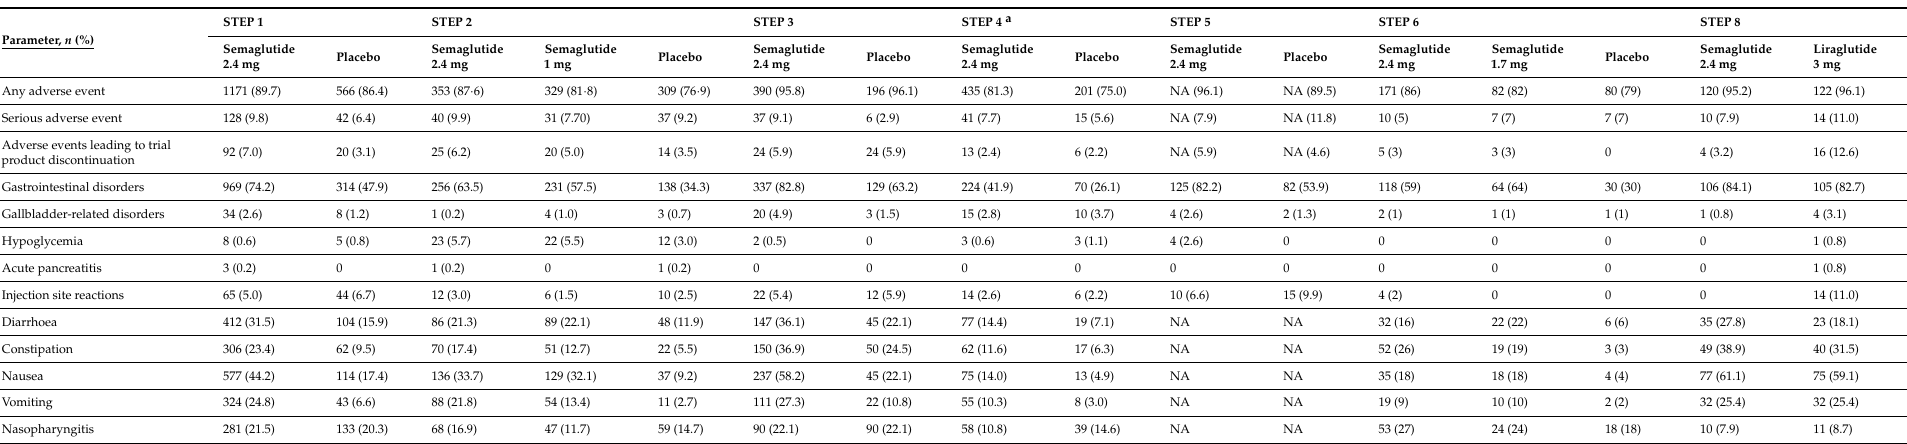
Table 3. Tolerability profile and main adverse events for STEP 1–6 and 8